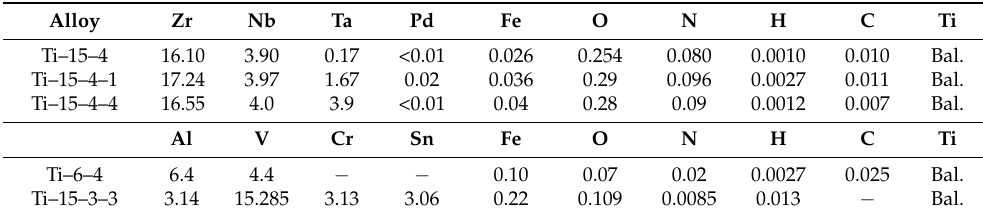
Table 1. Chemical compositions (mass%) of the three Ti–Zr alloys